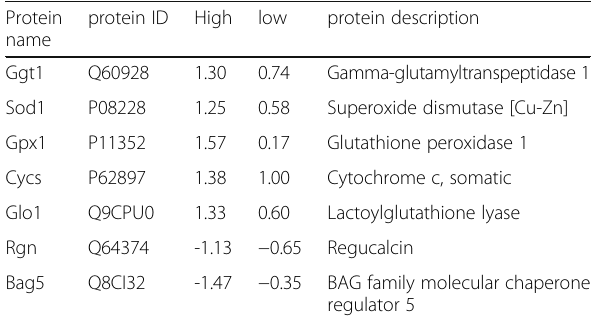
Table 2 Effect of SS on expression of proteins related to response to oxidative stress